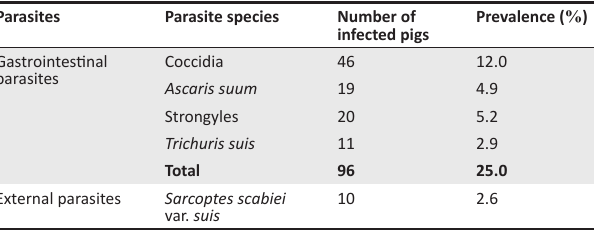
TABLE 1: Prevalence of parasites identified by faecal and skin scraping examina - tion in 384 pigs in Bishoftu. Parasites Parasite species Number of Prevalence ( % ) infected pigs Gastrointestinal Coccidia parasites